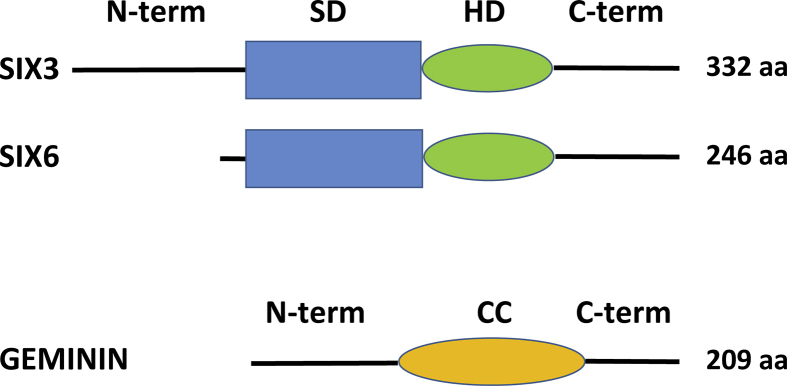
Schematic representation of the structure of the SIX3/SIX6 and GEMININ proteins. Structural elements of the SIX3/SIX6 include a well‐conserved Six domain (SD) and a homeodomain (HD) that is responsible for DNA binding. Structural elements of GEMININ include the coiled-coil domain (CC).